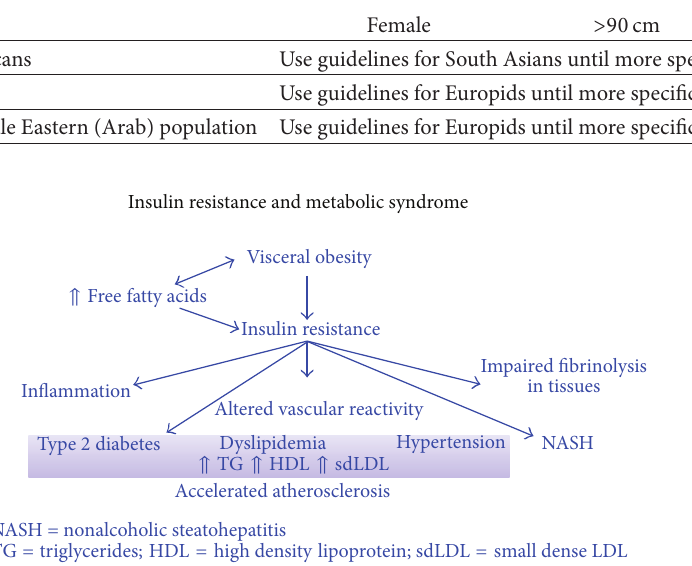
Figure 1: Pathophysiology of insulin resistance in metabolic syndrome [56].